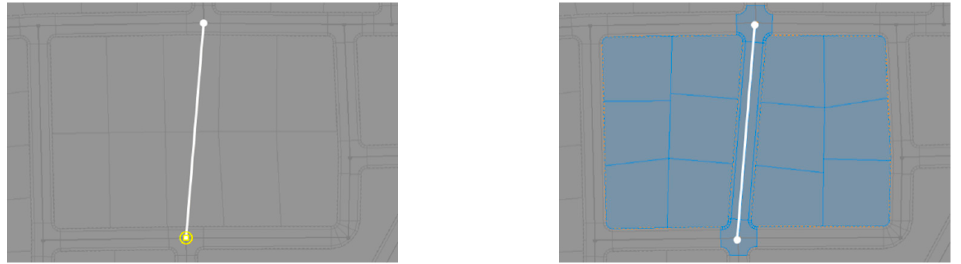
Figure 8. An alternative procedure for installing a new road using CityEngine.